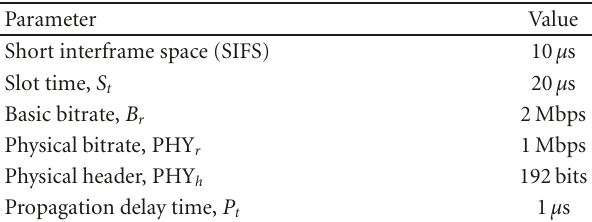
Table 2: System parameters and related